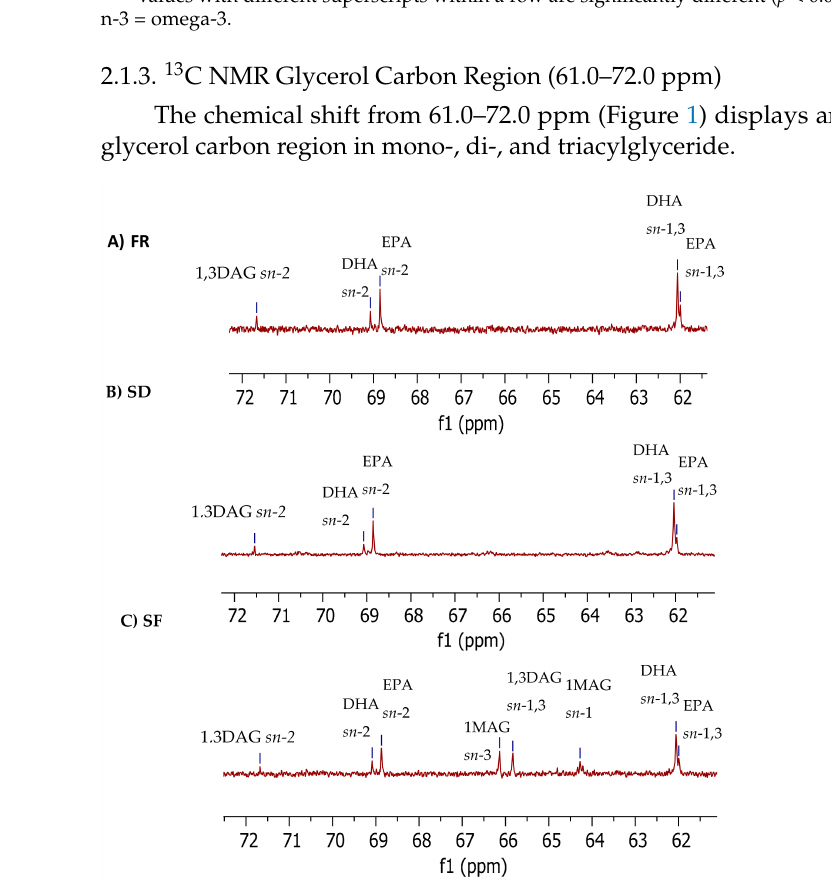
Figure 1. Glycerol carbon region of 13 C NMR spectra of fresh ( A ), salted ( B ), and fermented salmon ( C ) roe lipids. Chemical shift for glycerol carbon region is 72.0–61.0 ppm. Abbreviations: MAG = monoacylglycerol, DAG = di-acylglycerol, EPA = eicosapentaenoic acid, DHA = docosahex- aenoic acid. FR= raw or fresh salmon roe; SD = salted dried salmon roe; SF = fermented salmon